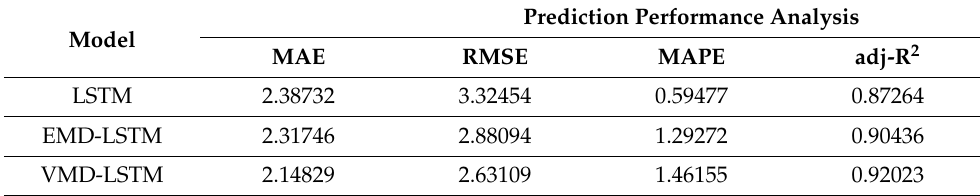
Table 3. Prediction performance analysis of single model and decomposed combined model.